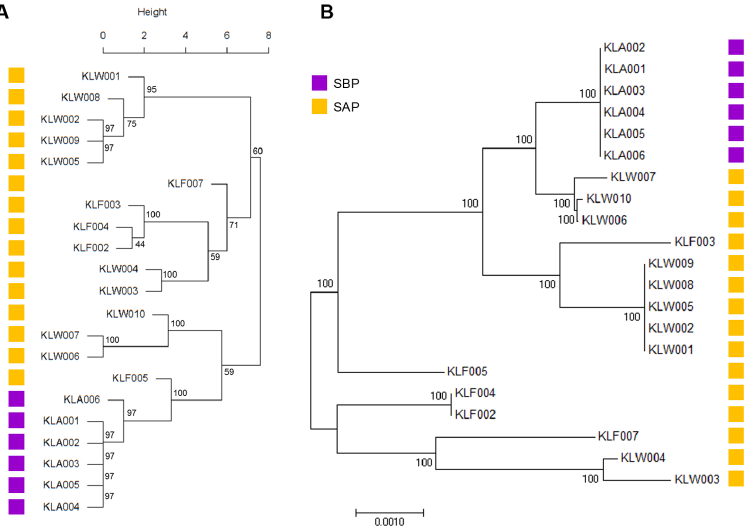
Fig 4. Phylogenetic clustering with EPS-related genes of SAPs and SBPs. (A) Tree basedon the presenceof 128 EPS-related genes of SAPs and SBPs. (B) Hierarchical clusteringbasedon amino acid sequencesof the 40 core genesfor EPS production. The bootstrapconsensustree inferred from 1,000 replicates is taken.